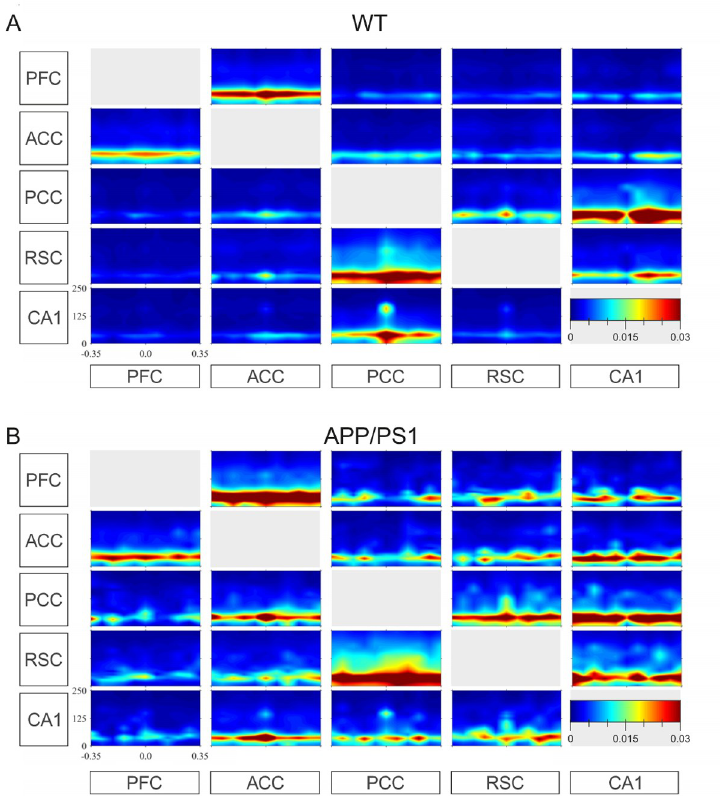
Fig 2. Time-frequency map of the effective coupling between CA1 and multiple cortical sites. dDTF plotted as function of time and frequency are averaged over WT (A) and APP/PS1 (B) groups. Every box shows effective coupling from the channel indicated below a given column to the channel indicated next to a given row. Time 0 indicates SWRs peak power. The color code indicates the value of the (130–180 Hz) and slow gamma (20–60 Hz) bands. Units: seconds (x-axis) and Hz (y-axis).